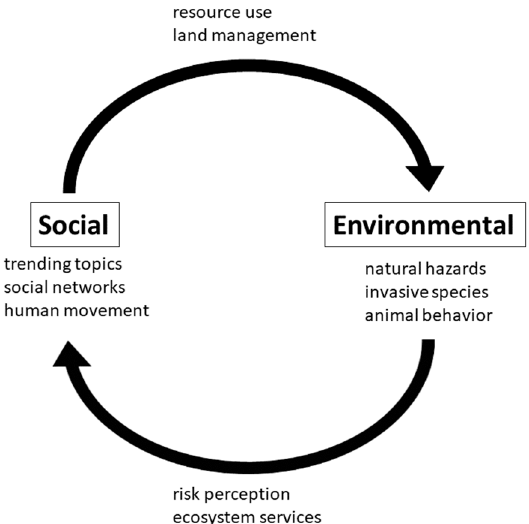
Figure 1. Socio-environmental systems (SES) diagram with examples of topics that have been researched using social media data, falling into four categories based on the aspect of SES they focus on (Social, Environmental, Social → Environmental, and Environmental → Social).